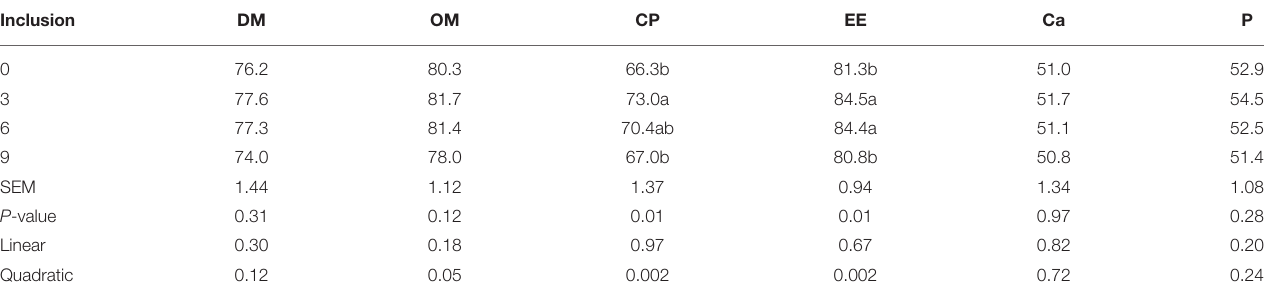
TABLE 3 | Effect of dietary low-inclusion levels of full-fatted black soldier fly larvae meal on apparent nutrient digestibility of layer chickens at 42 days of age (each value represents the mean of 6 replicates, %).